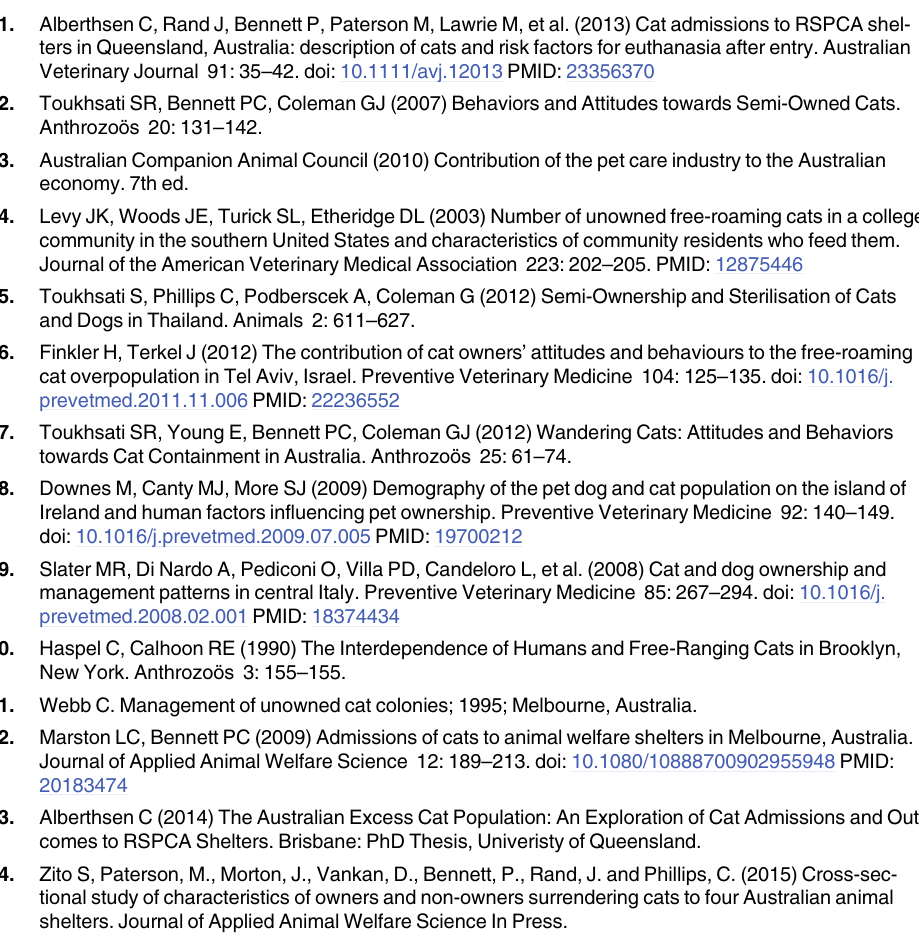
S2 Table. Distributions of study cats in semi-ownership and ownership human-cat rela- tionships and potential determinants of ownership perception that were not significantly associated with the perception of ownership of the study